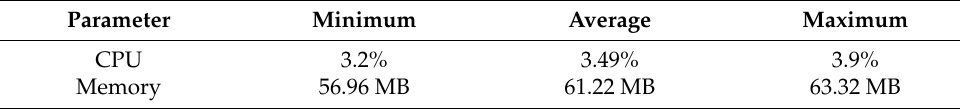
Table 8. DRAF overhead